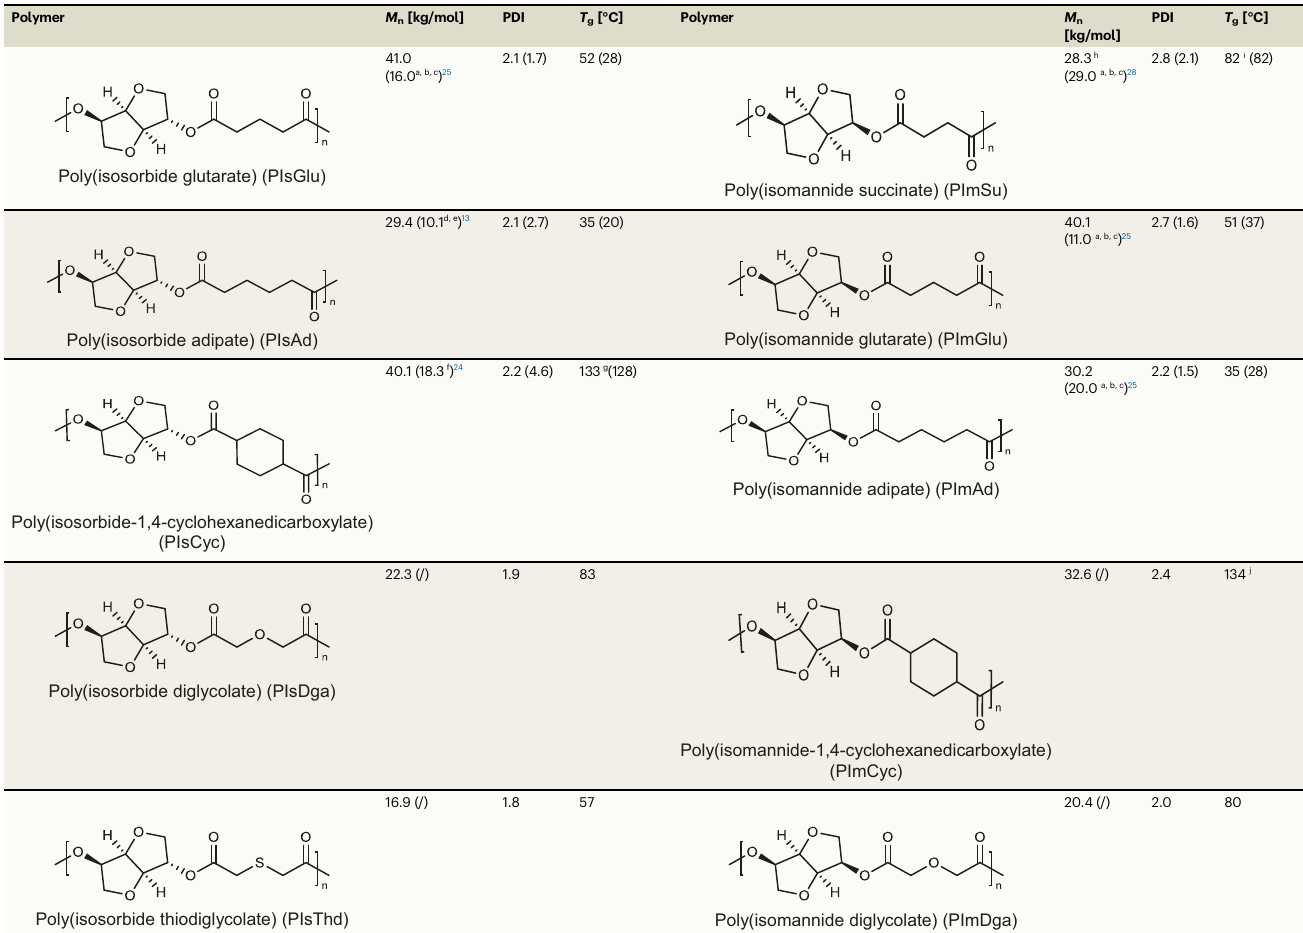
Poly(isosorbide glutarate)